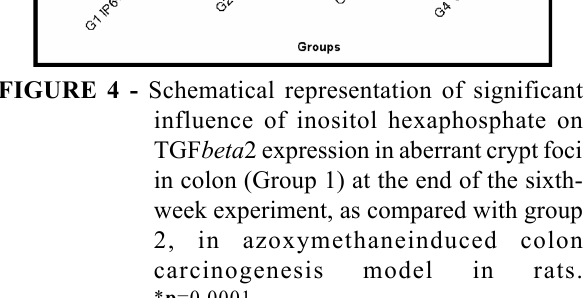
TABLE 1 - Immunohistochemistry results. Percentages of the captured areas of TGF- beta 2 expression in aberrant crypt foci in colon, as quantified through computerassisted image processing (ImageLab software) from immunohistochemistry-processed slides. Campo Grande, Brazil 2004.